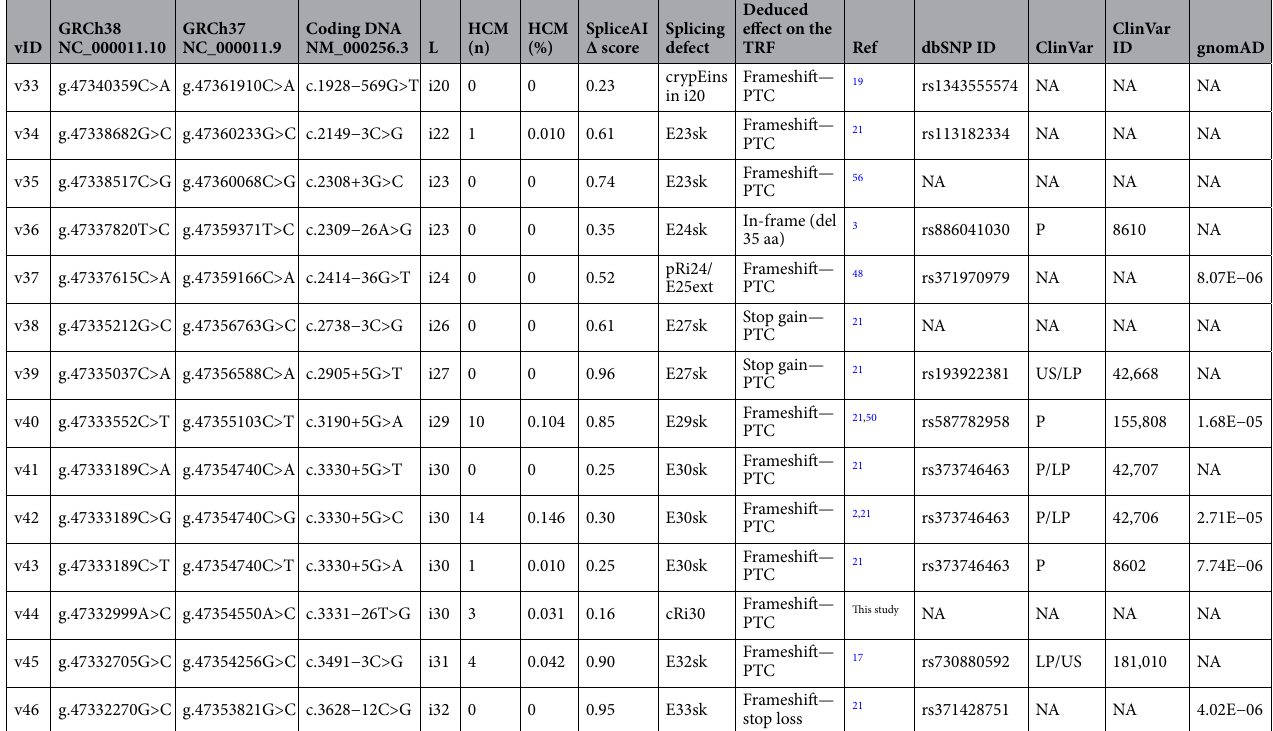
Table 1. Frequency of cryptic splice-altering MYBPC3 variants in a large cohort of HCM probands. vID— ID number assigned to each variant. Genomic (GRCh38 and Grch37 assembly versions) and coding